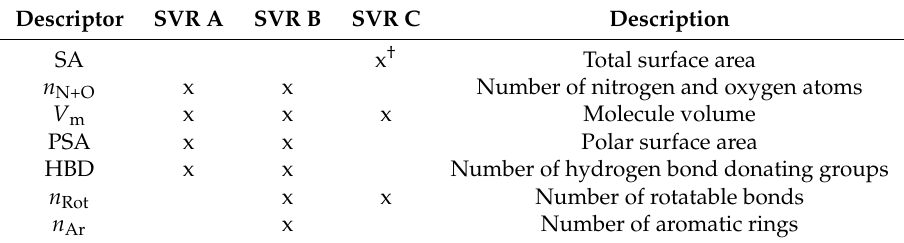
Table 1. Descriptor selected as the input of SVR models in the ensemble and their description.